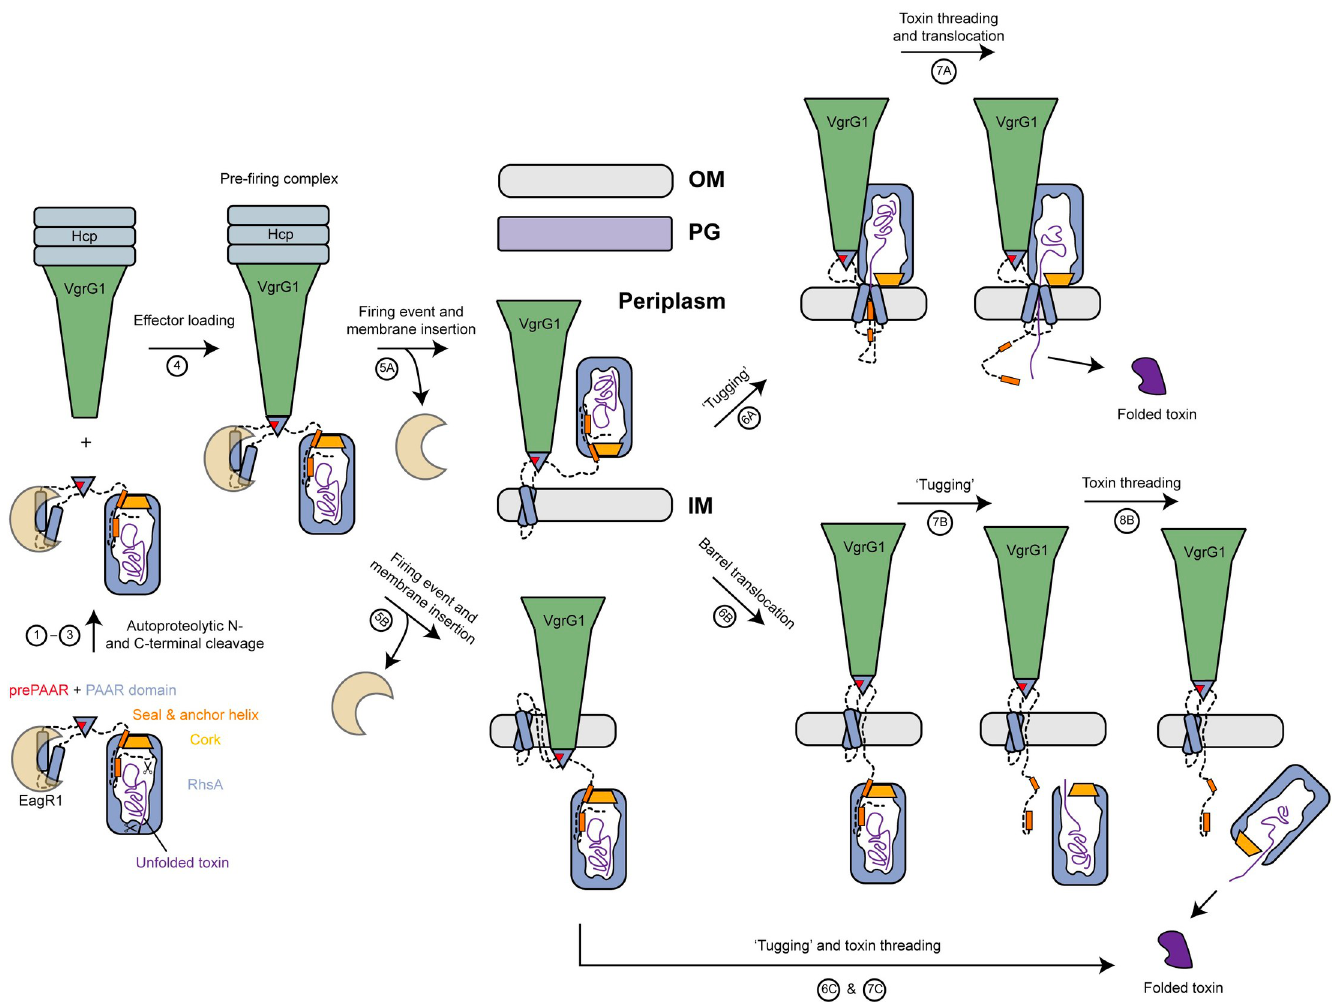
Fig 6. Model of T6SS-dependent delivery of RhsA into the cytoplasm of a susceptible bacterial cell. (1–3) RhsA undergoes N- and C-terminal autoproteolytic processing. The prePAAR motif ‘completes’ the PAAR domain fold. The EagR1 chaperone solubilizes the two transmembrane helices of RhsA to facilitate loading onto its cognate cytoplasmic VgrG1 (via the prePAAR + PAAR domain). (4) The secretion competent RhsA effector is loaded onto the VgrG1 spike. (5) During a firing event the EagR1 chaperone is dissociated from the complex and the T6SS injects the PFC into target cells where it crosses the peptidoglycan (PG) layer and inserts into the inner membrane (IM) (5A). Alternatively, the tip of the VgrG1 spike could be directly delivered into the cytosol along with RhsA (5B). (6–8) Two different scenarios (6A or 6B,C) are proposed as possible mechanisms for toxin domain release from the cocoon into the cytosol of the target cell. Either the toxin domain alone (mechanism 6A) or the entire RhsA barrel is translocated across the inner membrane (mechanism 6B). In both cases, the seal of the cocoon is likely removed by translocation-induced pulling and the energy required for release and translocation of the toxin domain out of the Rhs cage is probably driven by its spontaneous refolding in the prey bacterium’s